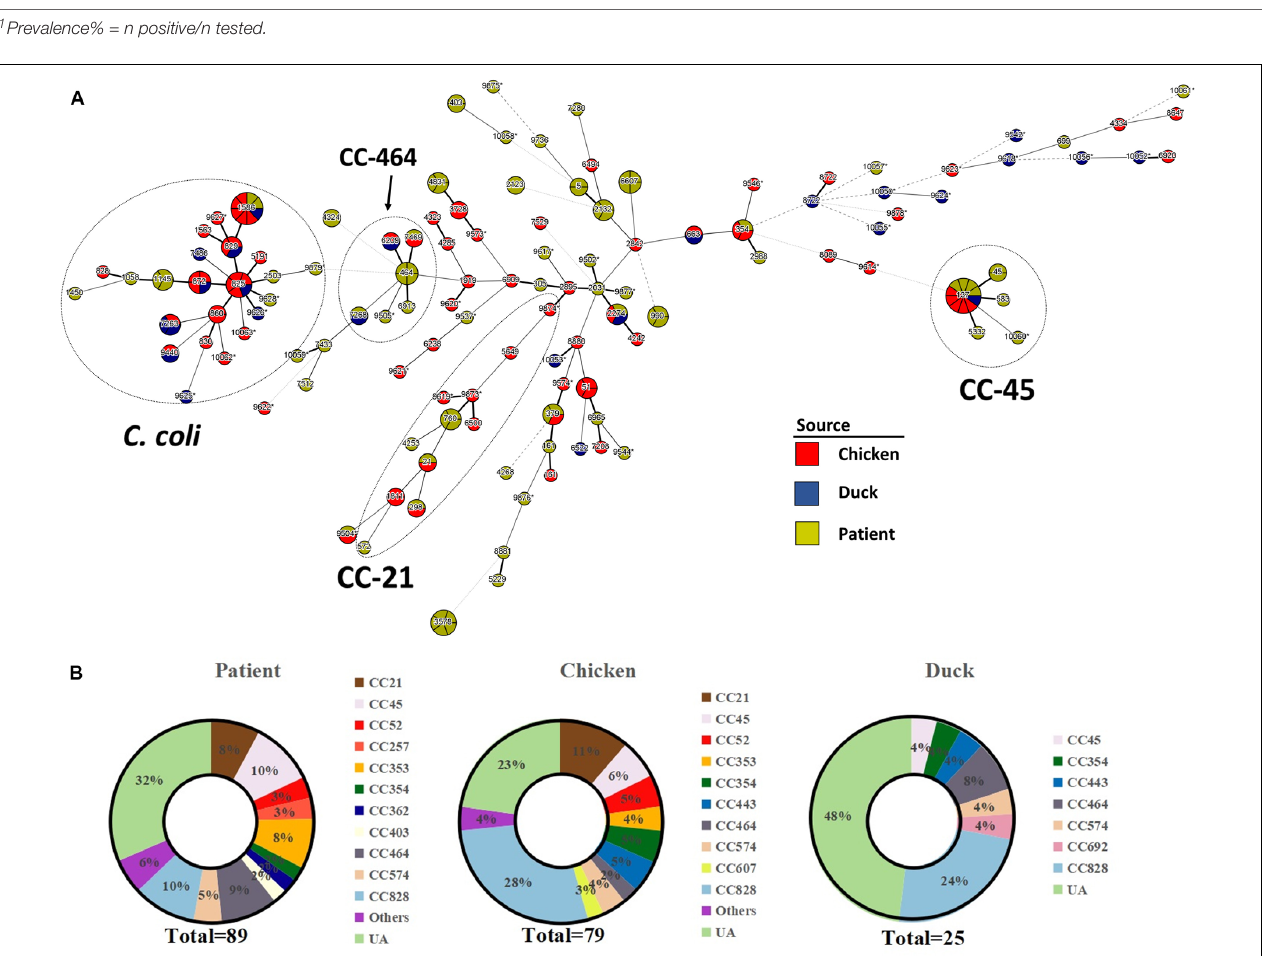
FIGURE 1 | Clonal distribution analysis of Campylobacter spp. (A) Minimum spanning tree based on MLST data from 193 Campylobacter strains. Sources are distinguished by color differences (chicken, red; duck, blue; diarrheal patient, yellow). Different circles correspond to different STs. Size of circle indicates number of isolates within the same ST, and thickness of the branches represents the degree of similarity among Campylobacter tested. A bold solid line indicates that one allele is different according to the length. Two to three allele differences are represented by a thin solid line, and four is indicated by a wide-interval dotted line. A narrow-interval dotted line shows that there is a five-allele difference between STs. Nodes with fewer than three different alleles have been placed in the same cluster. Most STs in the circle of C. coli are assigned to CC-828, except ST-9625, ST-9440, ST-7263, and ST-1450. Asterisk indicates newly designated ST in this study. (B) Proportion of MLST clonal complexes in each source. UA, unassigned